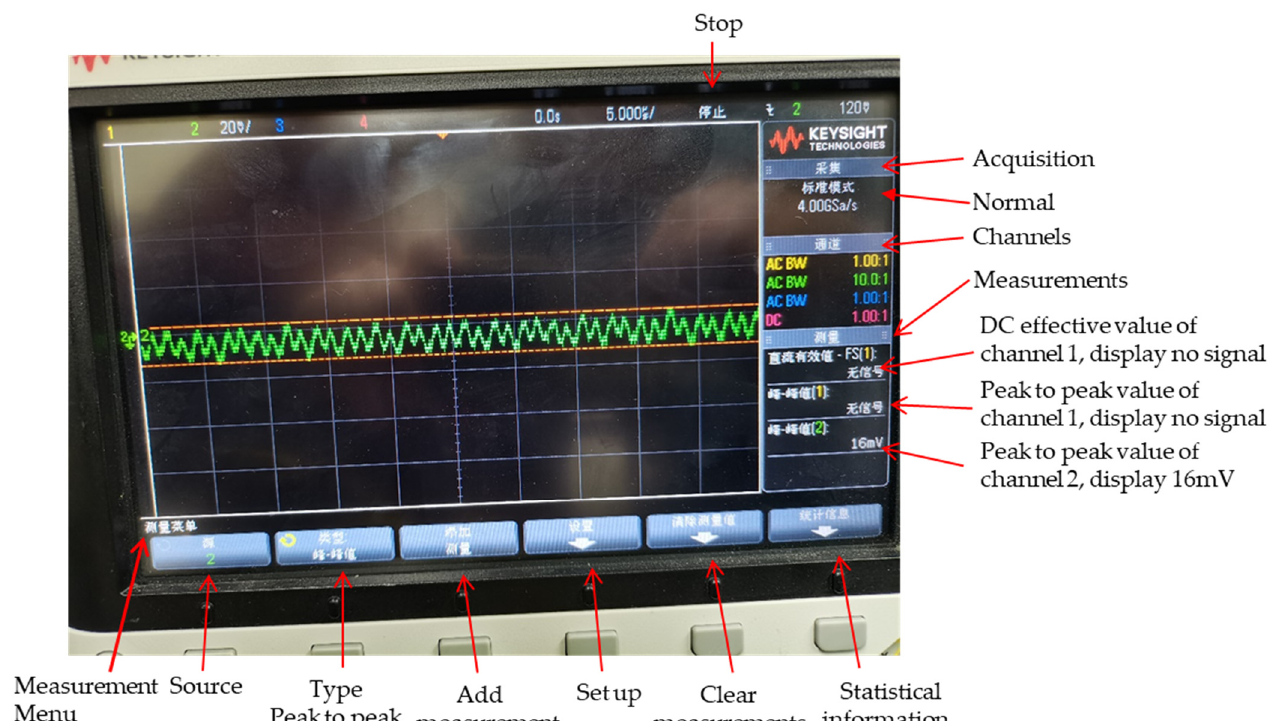
Figure 8. The ripple for positive input of the operational amplifier for generating VDCH bias volt- age.